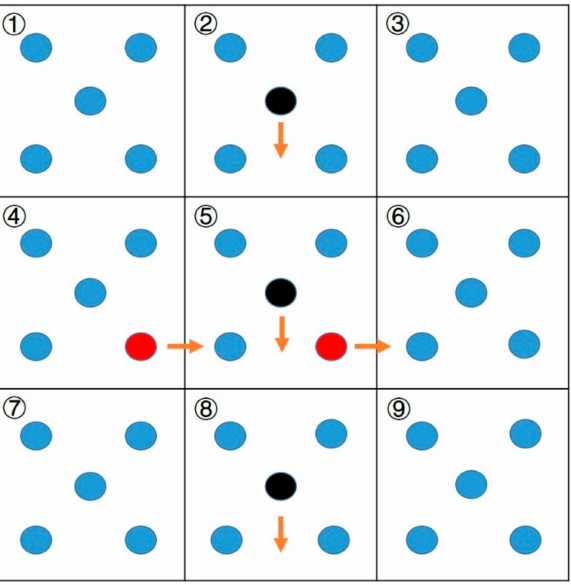
Figure 1. The schematic diagram of periodic boundary conditions. In the figure, the blue ball represents N particles in the box, while the black and red represent random particles in the box. The arrow represents the direction of movement of the particles, and the direction of movement is also